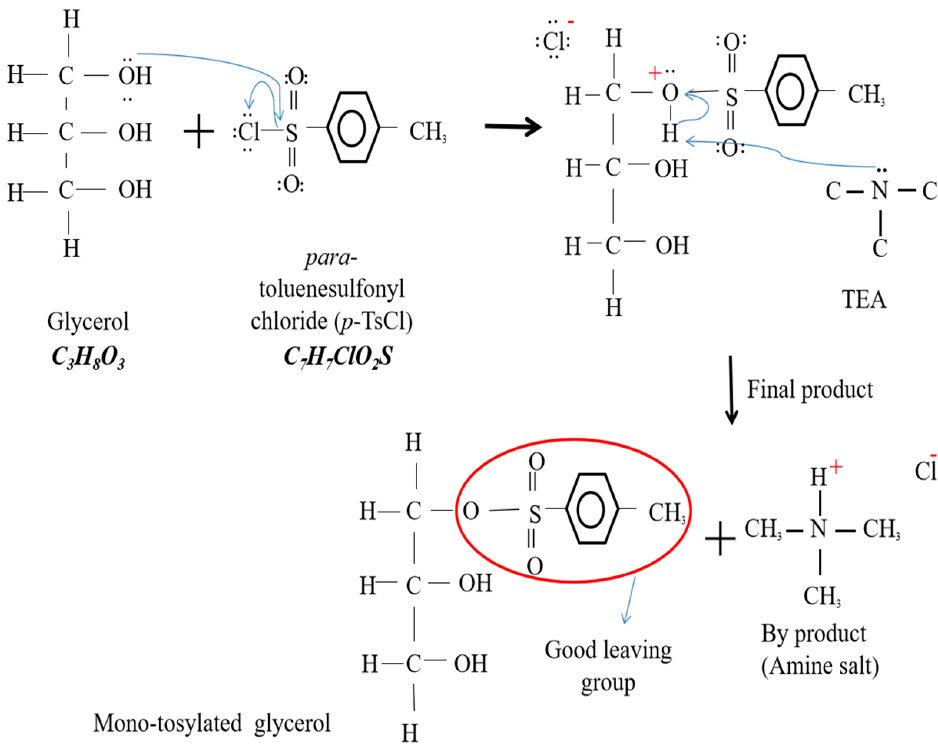
Figure 2. Tosylation reaction of tosylated glycerol production.